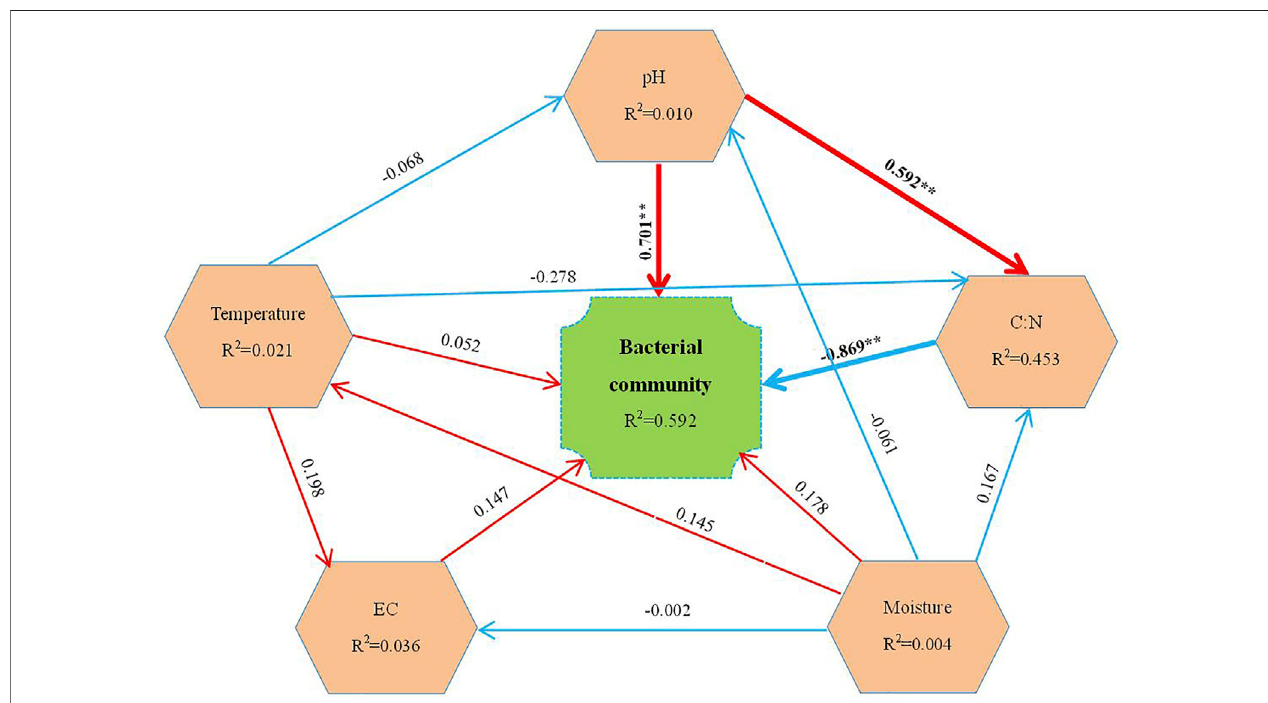
FIGURE6| Thederivedstructuralequationmodel(SEM)linkingtheenvironmentalfactorstothetotalbacterialcommunitystructure.Thepathcoef fi cientsaregiven adjacent to the arrows. Blue and red lines respectively indicate the negative and positive pathways. The signi fi cance levels are indicated by *( p < 0.05), **( p < 0.01).